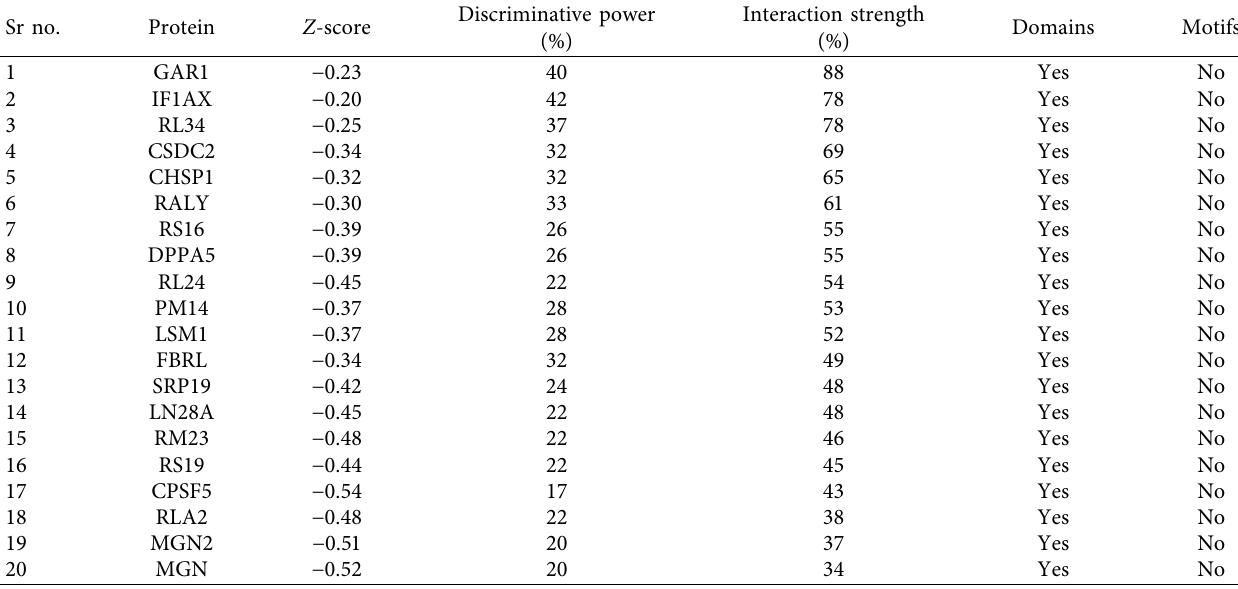
Table 2: CatRAPID profling suggests that various RBPs interact with UTRs. 3 ′ UTR catRAPID profle: list of RBPs interacting with SARS-CoV-2 3 ′ UTRs.